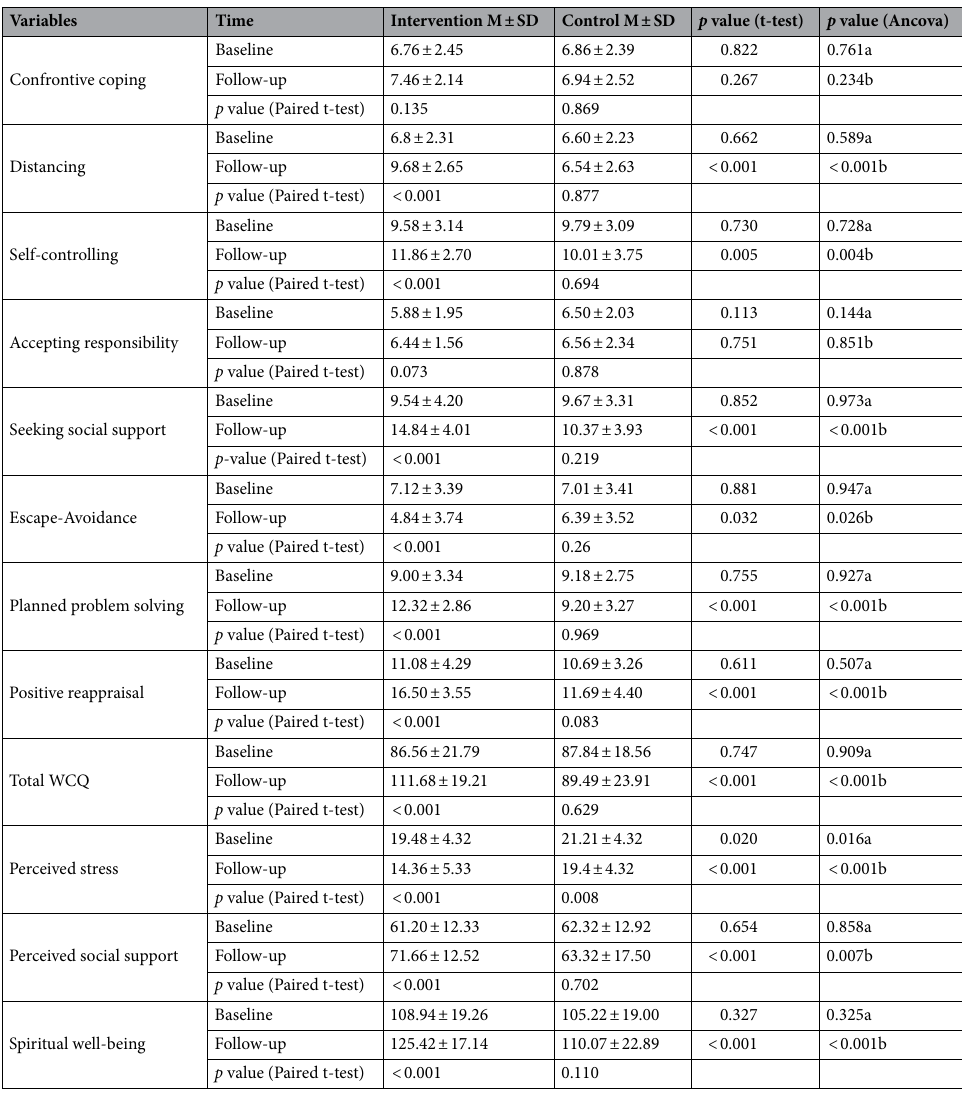
Table 3. Comparison of mean scores of variables at baseline and at 3 ‐ month follow ‐ up according to group. a : Adjusted for Sex by ANCOVA; b : Adjusted for Sex and baseline value by